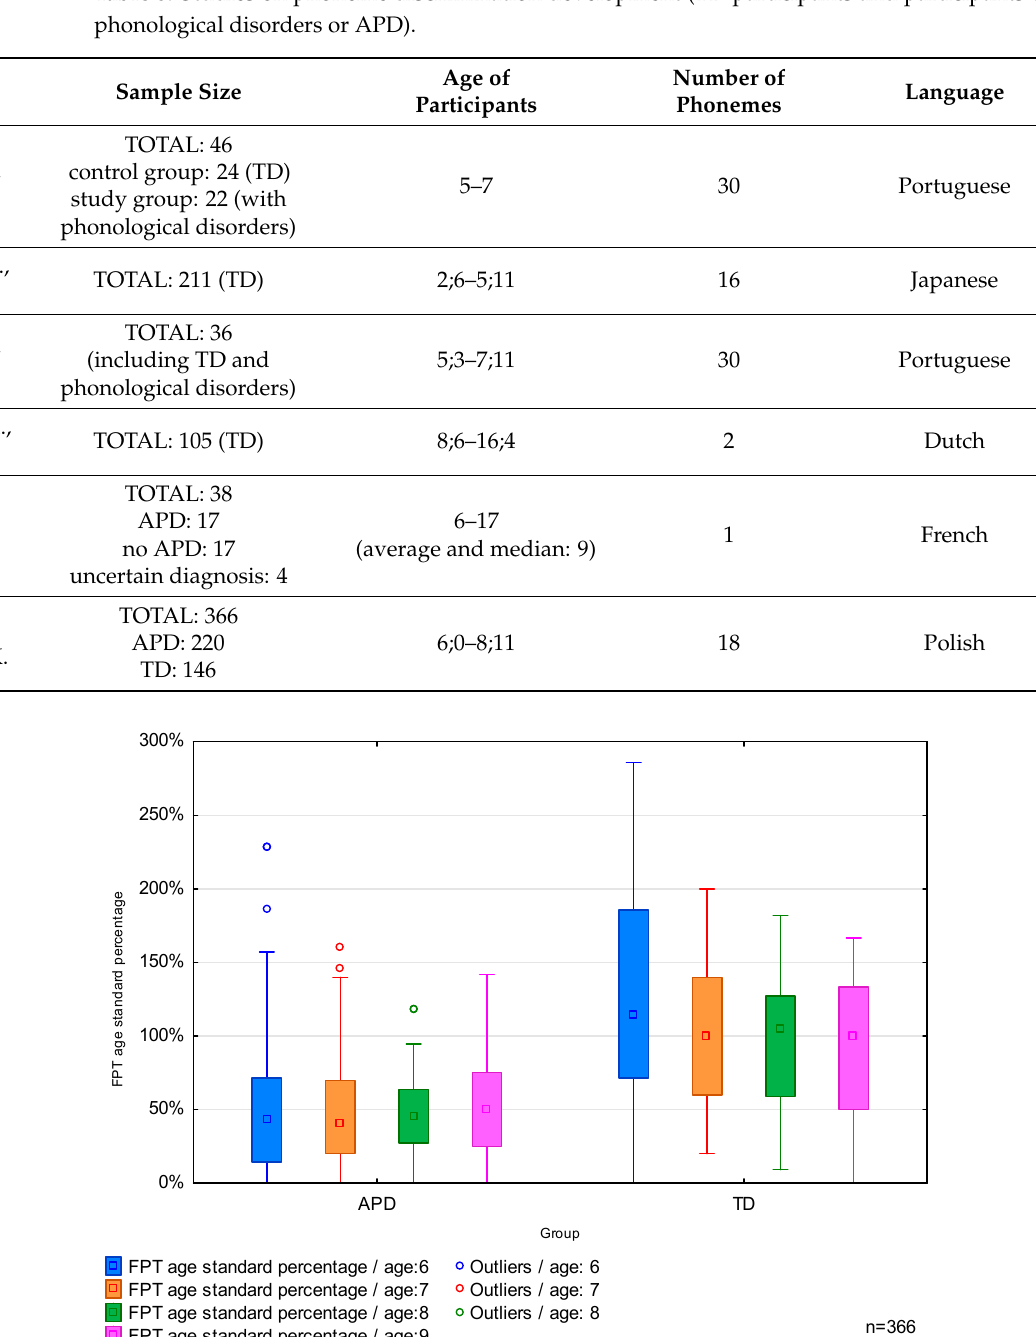
Figure 3. Results of the FPT test (age standard percentage), in 6, 7, 8, and 9 ‐ year ‐ olds, in APD and TD groups.